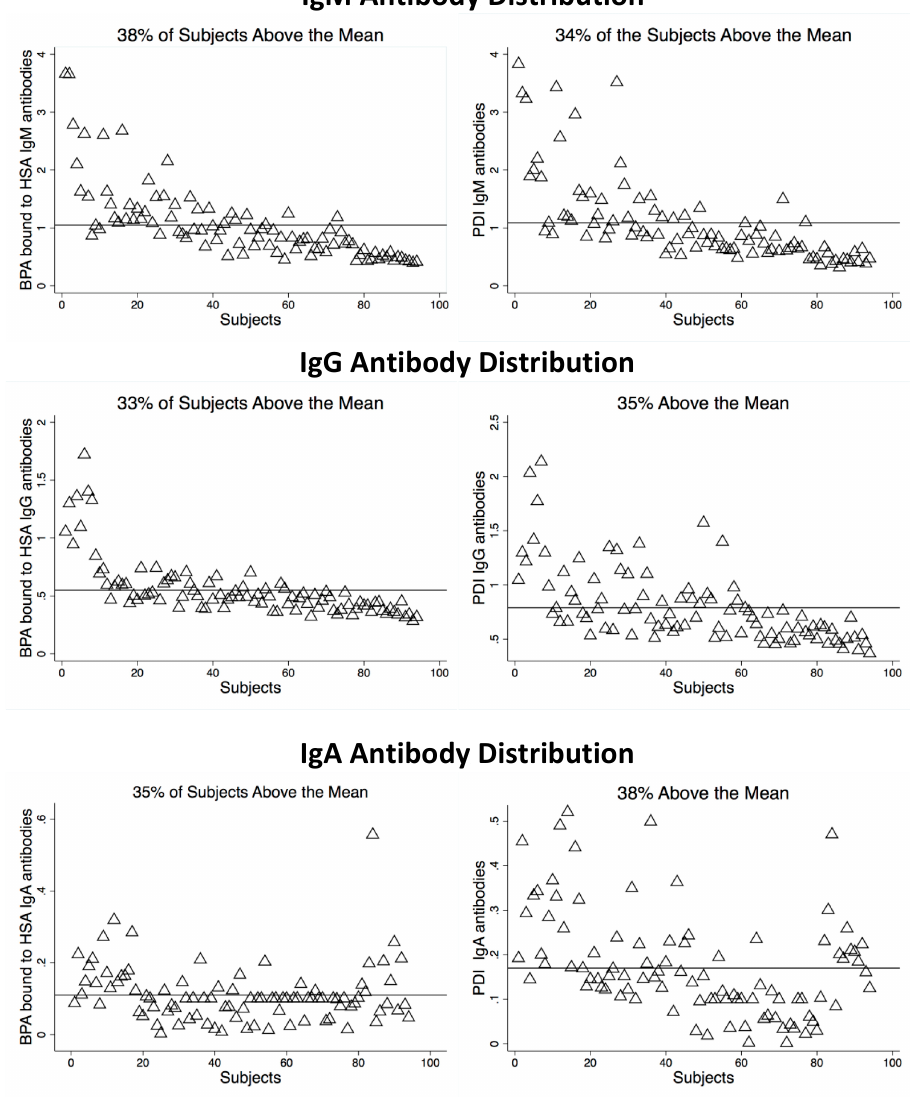
Figure 2. Optical density levels of BPA bound to HSA and PDI.